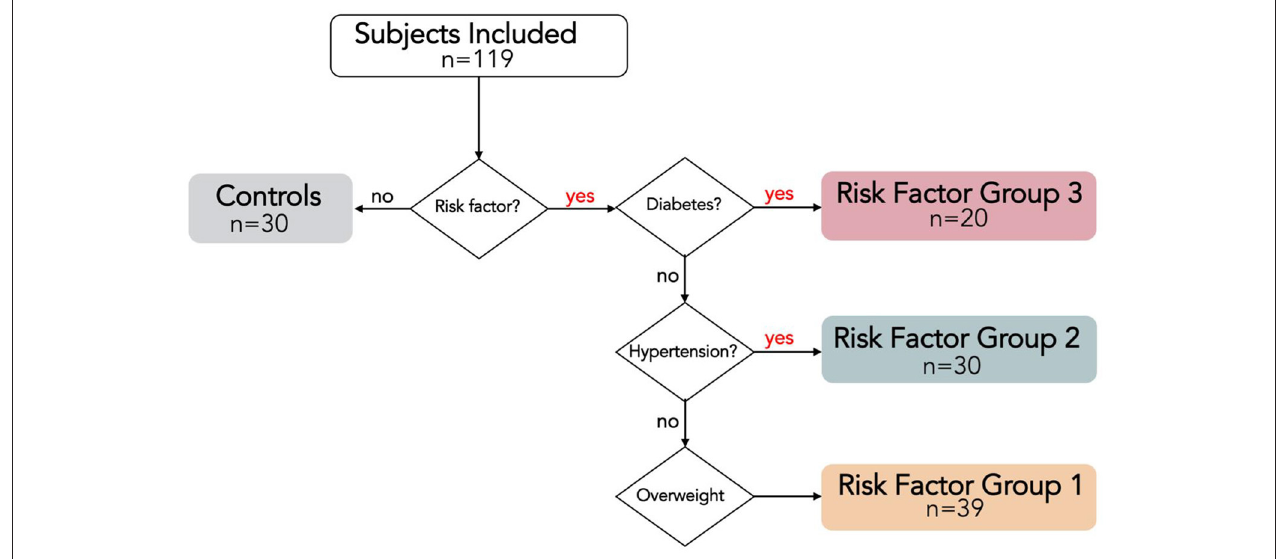
FIGURE 1 | Risk Factor Group (RFG) classifications visualized with a flow chart. RFG3 includes all type 2 diabetes mellitus (T2DM) subjects, regardless of the presence of hypertension or overweight. RFG2 includes all hypertensive subjects without T2DM, regardless of the presence of overweight. RGF1 includes all overweight subjects without hypertension and